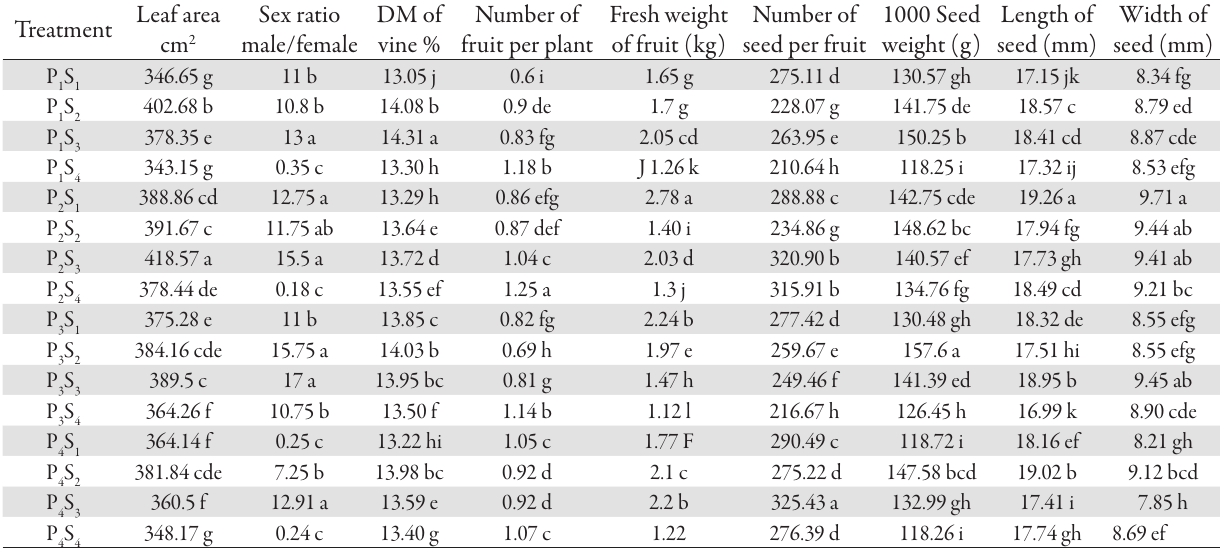
Tab. 2. Effect of PGRs on growth and yield characteristics on ( Cucurbita pepo var . styriaca cv. ‘Kaki’) in farming method Leaf area Treatment cm